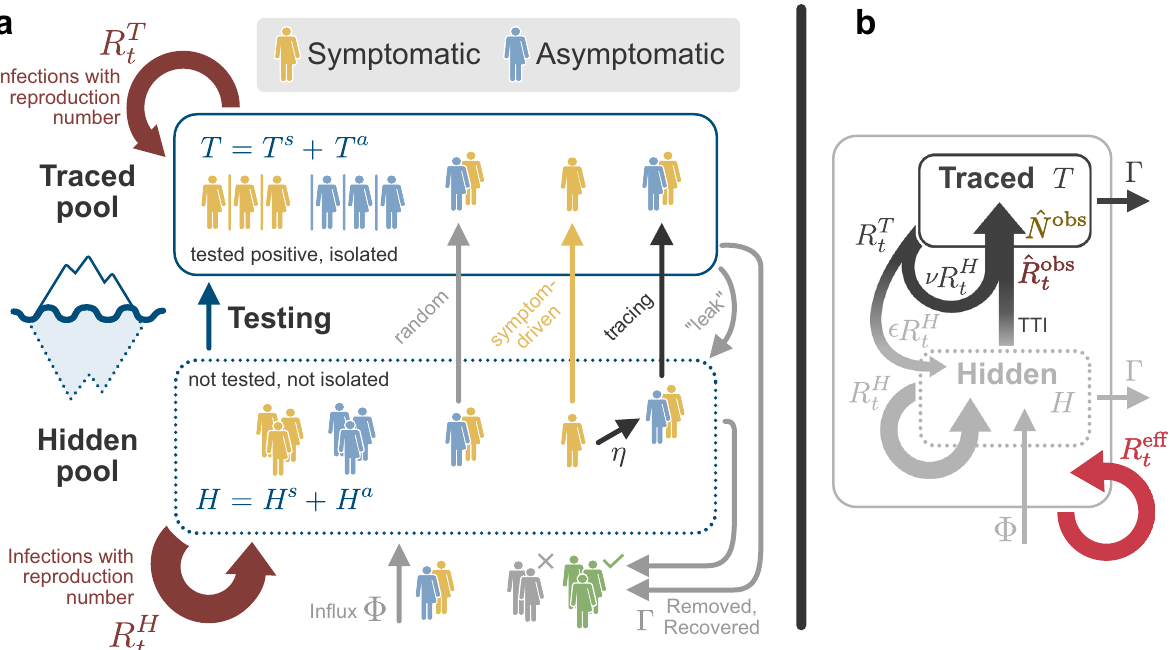
Fig. 1 Illustration of interactions between the hidden H and traced T pools in our model. a In our model, we distinguish two different infected population groups: the one that contains the infected individuals that remain undetected until tested (hidden pool H ), and the one with infected individuals that we already follow and isolate (traced pool T ). Super indexes s and a in both variables account for symptomatic and asymptomatic individuals. Until noticed, an outbreak will fully occur in the hidden pool, where case numbers increase according to this pool ’ s reproduction number R H t . Testing and tracing of hidden infections transfers them to the traced pool and helps to empty the hidden pool; this prevents offspring infections and reduces the overall growth of the outbreak. Due to the self-isolation imposed in the traced pool, its reproduction number R T t is expected to be considerably smaller than R H t , and typically smaller than 1. Once an individual is tested positive, all the contacts since the infection are traced with some ef fi ciency ( η ). Two external events further increase the number of infections in the hidden pool, namely, the new contagions occurring in the traced pool that leak to the hidden pool and an in fl ux of externally acquired infections ( Φ ). In the absence of new infections, pool sizes are naturally reduced due to recovery (or removal), proportional to the recovery rate Γ . b Simpli fi ed depiction of the model showing the interactions of the two pools. New infections generated in the traced pool can remain there ( ν ) or leak to the hidden pool ( ϵ ). Note that the central epidemiological observables are highlighted in color: The ^ N obs (brown) and ^ R obs t (dark red) can be inferred from the traced pool, but the effective reproduction number ^ R eff t (light red) that governs the stability of the whole system remains hidden.